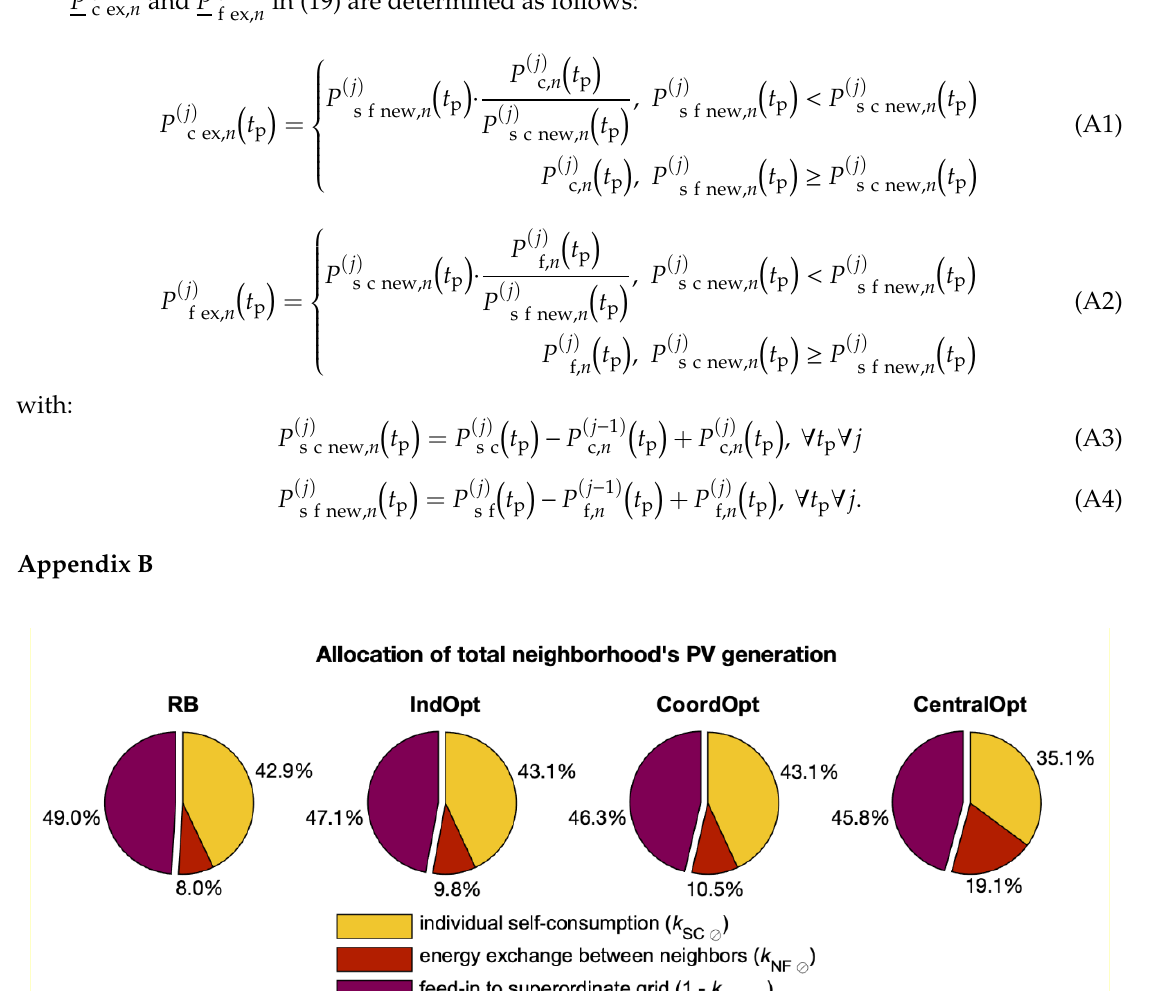
Figure B2. Individual degrees of self-consumption and neighborhood feed-in ratios for all households (In: IndOpt, Co: CoordOpt, Ce: CentralOpt, H: household). References 1.